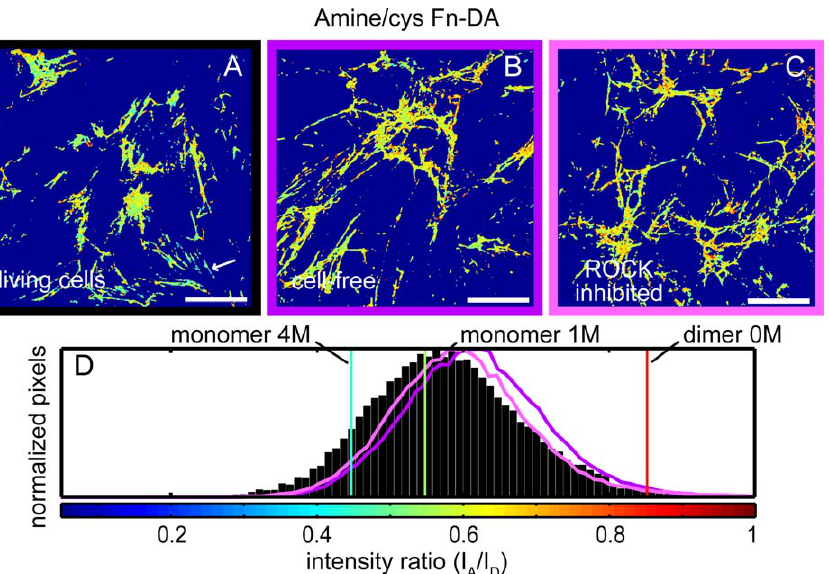
Figure 4. Matrix Refolding after Cell Extraction or ROCK Inhibition Amine/cys Fn-DA and excess Fn-u were added to the culture medium of fibroblasts for 24 h. Color-coded I A / I D ratiometric images are shown for control cells (A), extracted cell-free matrix (B), and fibroblast cells after 60 min exposure to the ROCK inhibitor Y-27632 (C). Histograms with 0.01-ratio-unit bin widths for all pixels of control (black), cell-free (purple), and ROCK-inhibited matrix (pink) were derived from three random fields of view each from three separate experiments in each group (D). Solution denaturation values for dimeric Fn-DA in 0 M GdnHCl and monomeric Fn-DA in 1 and 4 M GdnHCl are shown as red, green, and blue lines, respectively. Scale bars ¼ 50 l m.